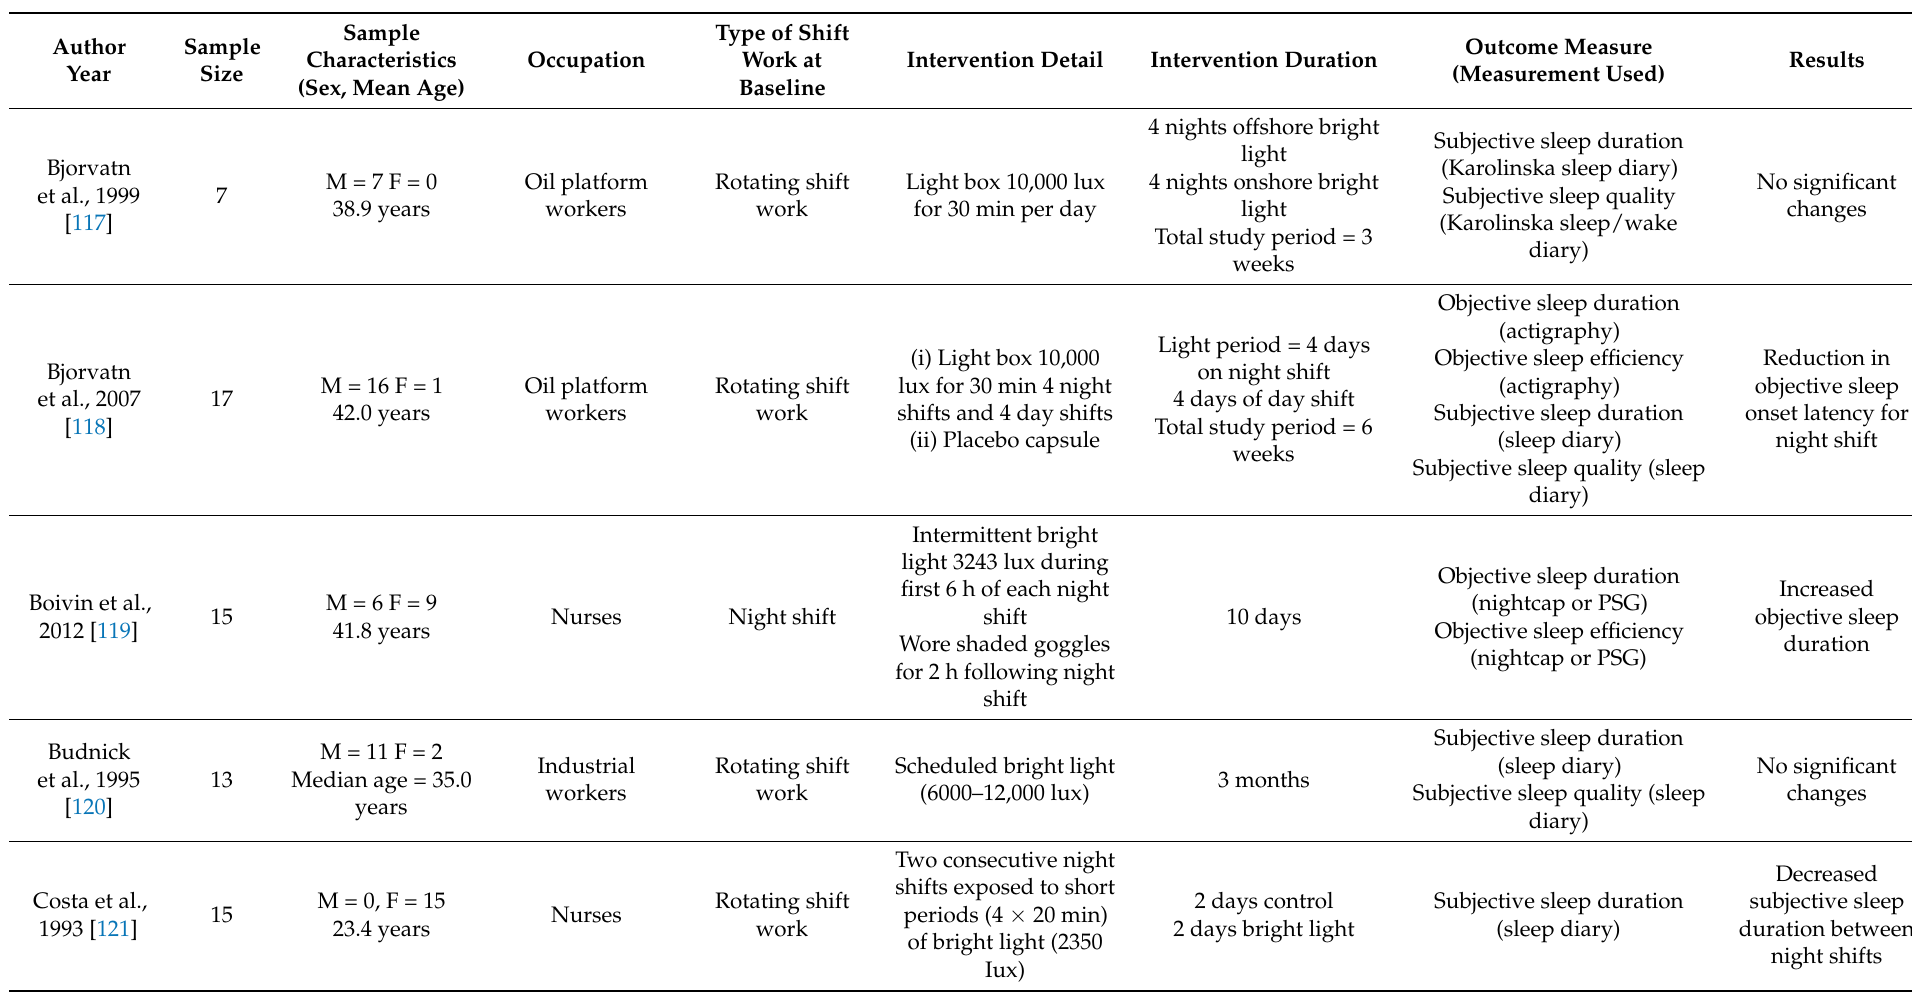
Table 5. Studies investigating controlled light exposure